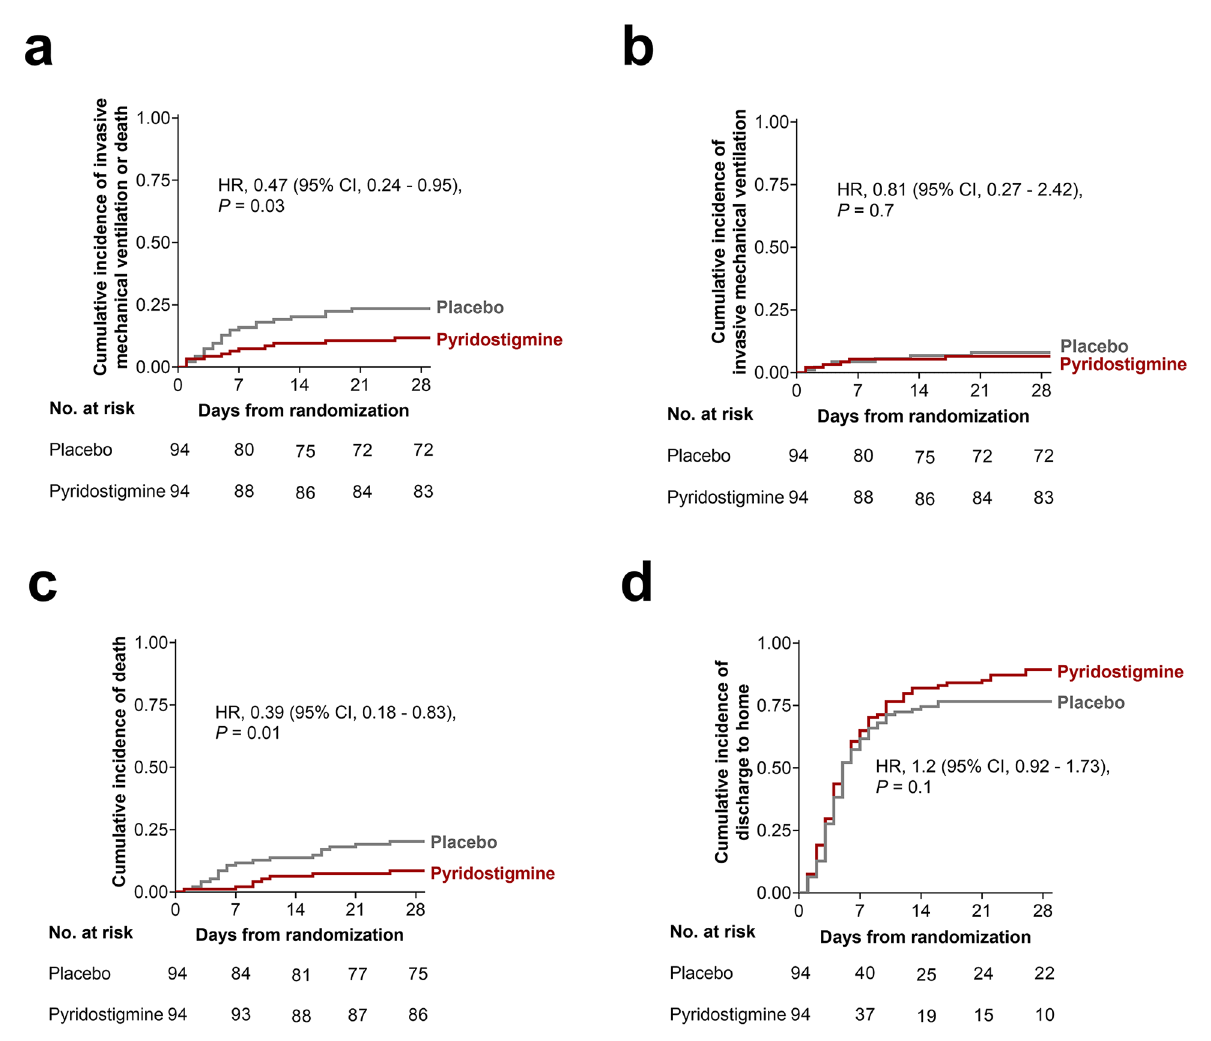
Fig. 2 Pyridostigmine administration reduces mortality in patients with severe COVID-19. (a) Cumulative incidence of mechanical ventilation or death by day 28 as the composite outcome; (b) cumulative incidence of mechanical ventilation day 28; (c) cumulative incidence of death by day 28;and,(d) cumulative incidence of discharge home by day 28. Hazard ratios were calculated with Cox proportional hazards models and p-values were obtained with a log-rank test. In the case of IMV as the primary outcome, deaths without IMV were censored. In the case of death as the primary outcome, IMV was not